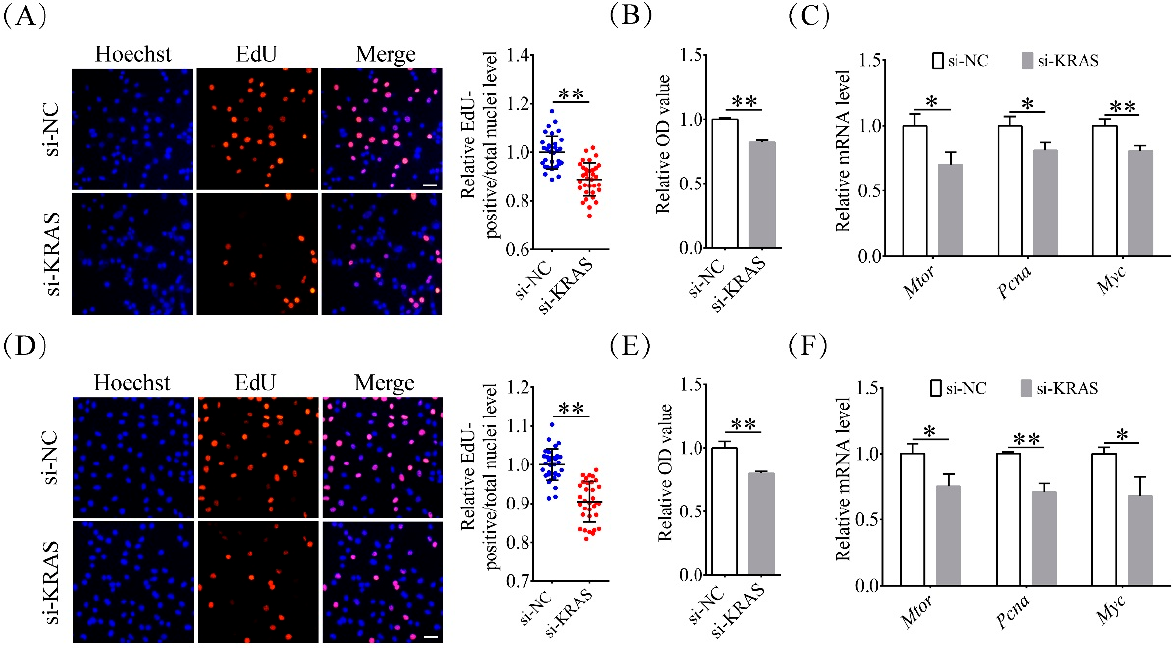
Figure 3. Effects of KRAS on cell proliferation in 3T3-L1 and C2C12 cells. ( A ) Representative 5-ethynyl-2 ′ -deoxyuridine (EdU) staining images and relative percentages of EdU-positive cells among 3T3-L1 cells with or without KRAS inhibition. Scale bar = 50 µ m. Significant differences are represented with ** ( p < 0.01). ( B ) Cell proliferation capacity assay results for 3T3-L1 cells with or without KRAS inhibition. Significant differences are represented with ** ( p < 0.01). ( C ) mRNA expression of mammalian target of rapamycin (Mtor) , proliferating cell nuclear antigen (Pcna) , and Myc in 3T3-L1 cells with or without KRAS inhibition. Significant differences are represented with * ( p < 0.05) and ** ( p < 0.01). ( D ) Representative EdU staining images and relative percentages of EdU-positive cells among C2C12 cells with or without KRAS inhibition. Scale bar = 50 µ m. Significant differences are represented with ** ( p < 0.01). ( E ) Cell proliferation capacity assay results for C2C12 cells with or without KRAS inhibition. Significant differences are represented with ** ( p < 0.01). ( F ) mRNA expression of Mtor , Pcna, and Myc in C2C12 cells with or without KRAS inhibition. Significant differences are represented with * ( p < 0.05) and ** ( p < 0.01).